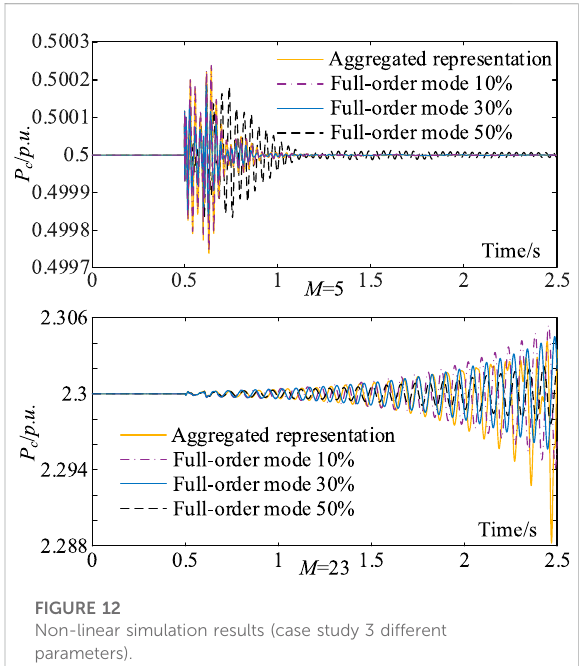
FIGURE 12 Non-linear simulation results (case study 3 different